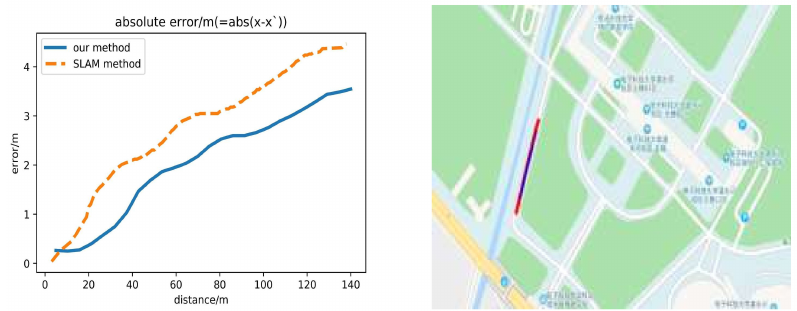
Figure 11. Absolute positioning error of straight road